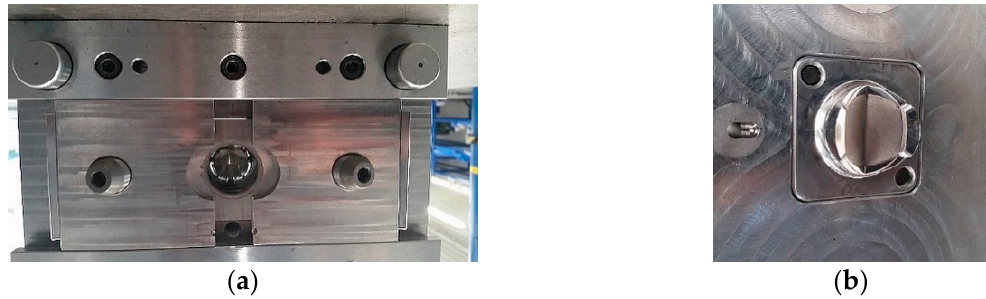
Figure 8. Injection mold for the ring of the outflow valve: ( a ) mold seat and ( b ) mold stamp.